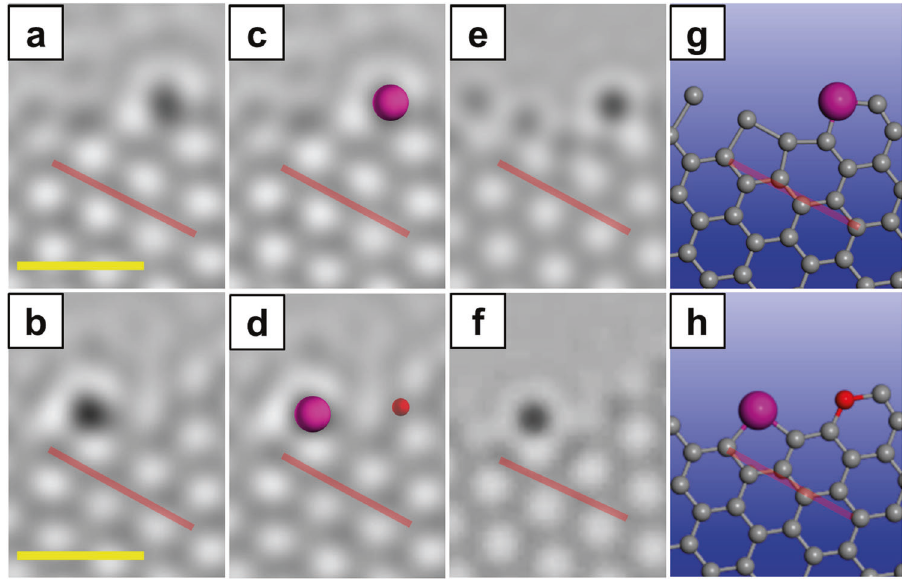
Fig. 9 Catalytic growth (C incorporation) at a graphene edge by a diffusing Ni SAC. a – b HRTEM images showing the Ni atom before and after catalytic activity. c – d HRTEM images with added balls to aid viewing. Ni is rose colored and the added C atom is in red. e – f Image simulations of the HRTEM images. g – h Complete stick-and-ball models of the structures used for the image simulations. Note: The red line is the reference line. All scale bars are 5 Å.